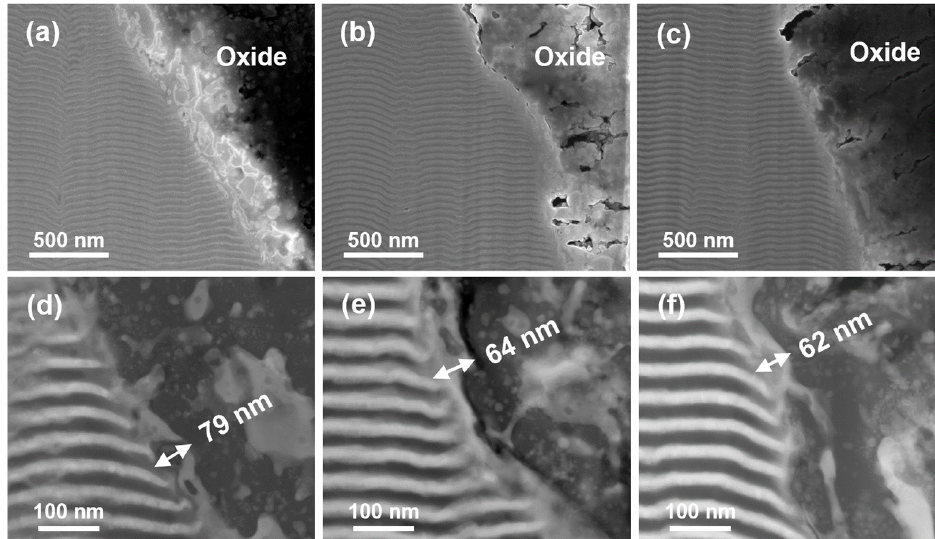
Figure 4. Top row: secondary electron SEM images of TEM samples taken from the laser cut edge of ultrasonically cleaned samples; ( a ) 100fs_1kHz, ( b ) 150fs_1kHz, ( c ) 150fs_5kHz. The original layer structure appears to be preserved up to a few hundred nm from the cut edge. Bo tt om row: STEM-in-SEM bright fi eld images of samples ( d ) 100fs_1kHz, ( e ) 150fs_1kHz, and ( f ) 150fs_5kHz. A thin mixing zone between the layers and the oxide can be seen.